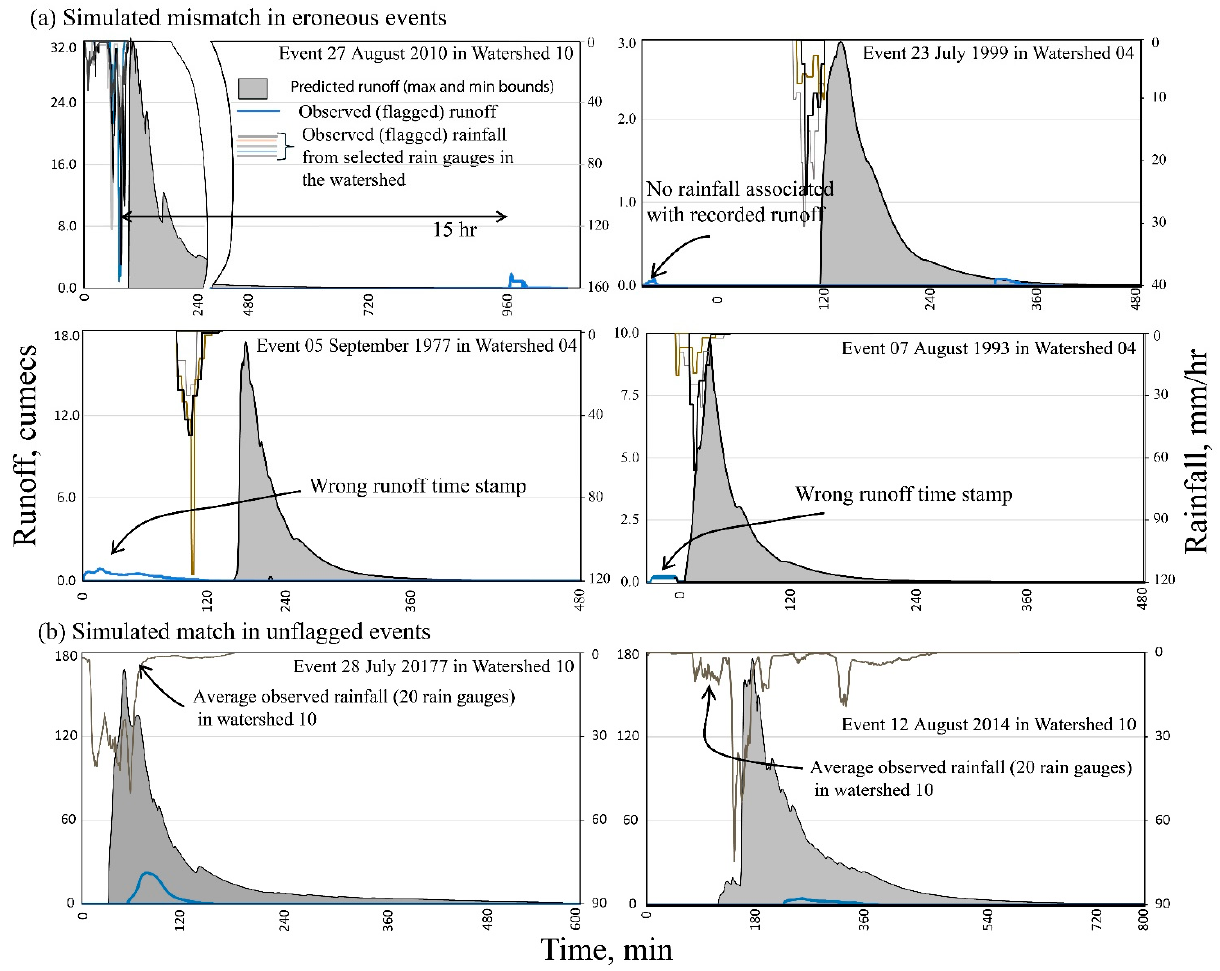
Figure 9. Event scale K2 modeling of runoff processes using flagged and unflagged events. The simulated runoff ranges (gray polygon) representing possible processes in Walnut Gulch and observed runoff (blue line). ( a ) Example of mismatch in flagged events simulation, and ( b ) Examples of unflagged events simulation representing error-free data.